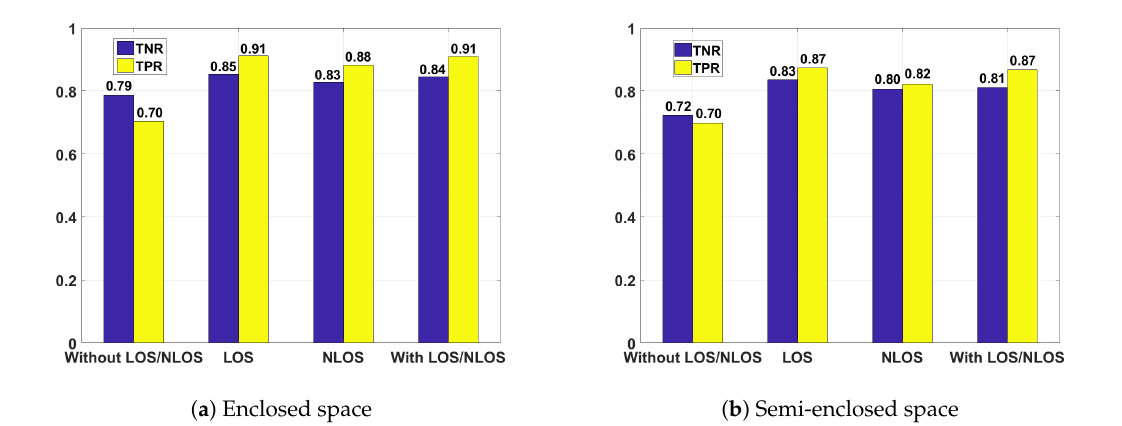
Figure 15. Performance results under different